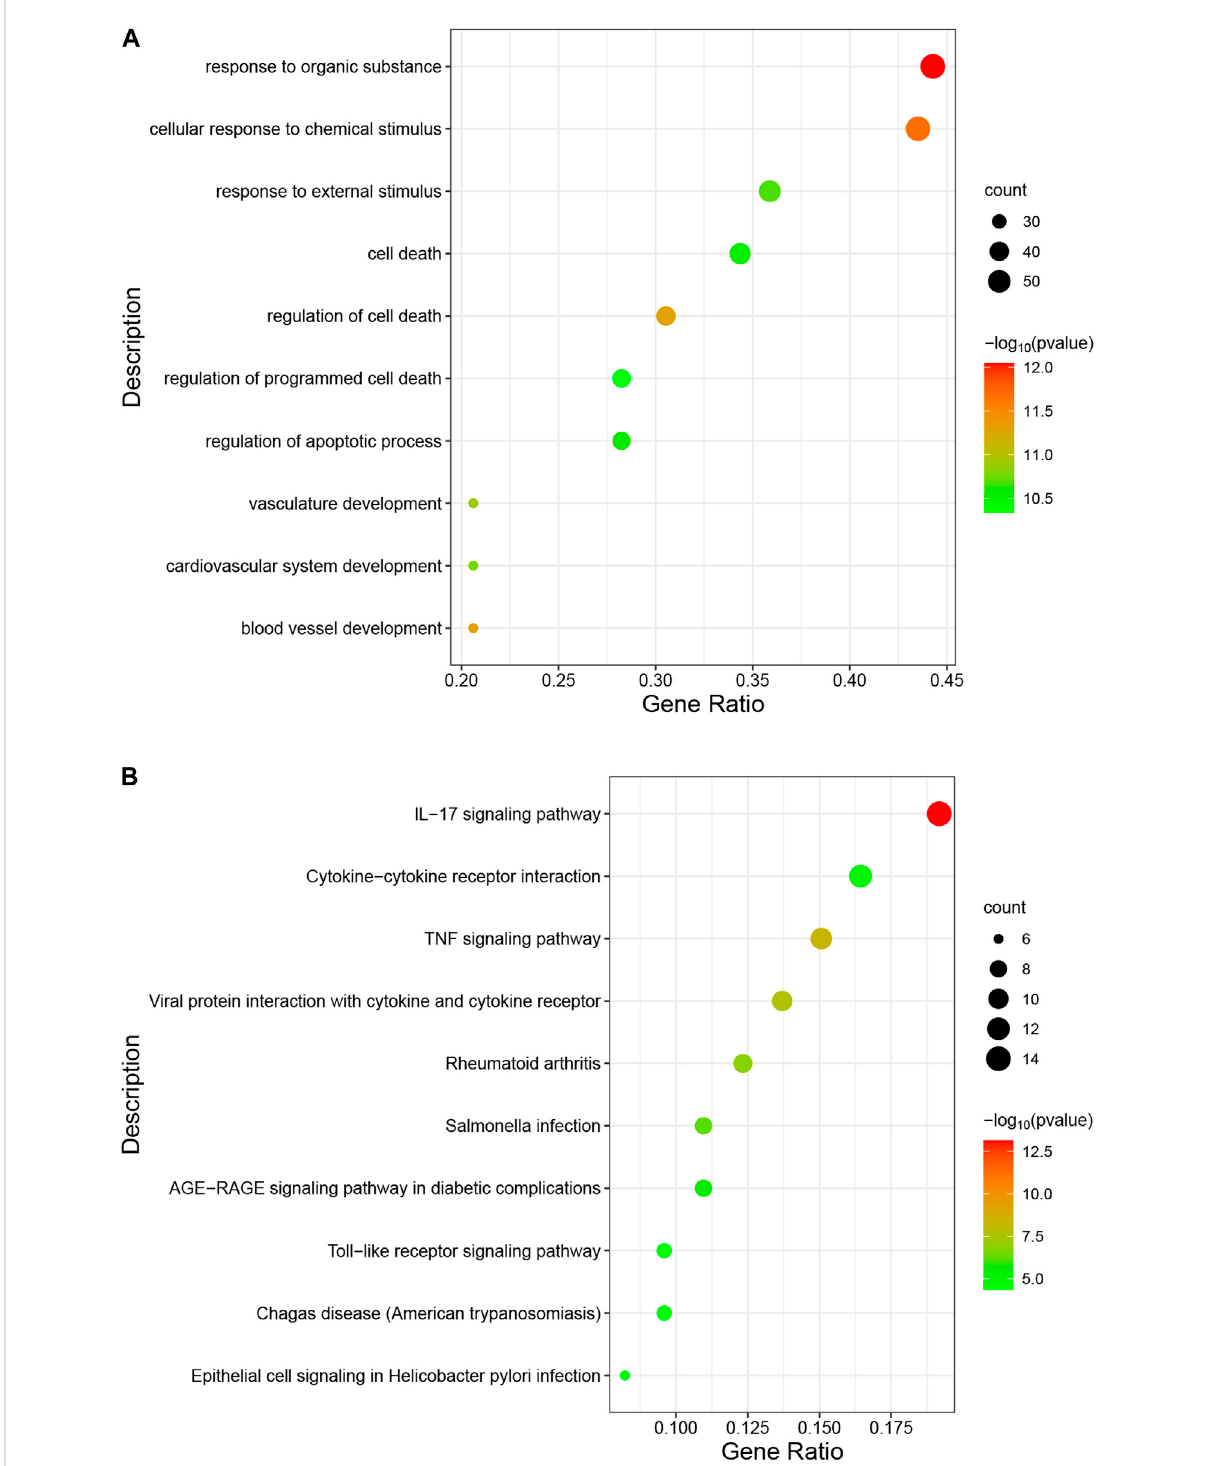
FIGURE 5 Analysis of functional enrichment for intersecting common genes. (A) , bubble diagram of GO analyses for common genes. (B) , bubble diagram of KEGG analyses for common genes. The number of genes is indicated by the size of the circle, whereas the p -value is shown in gradient